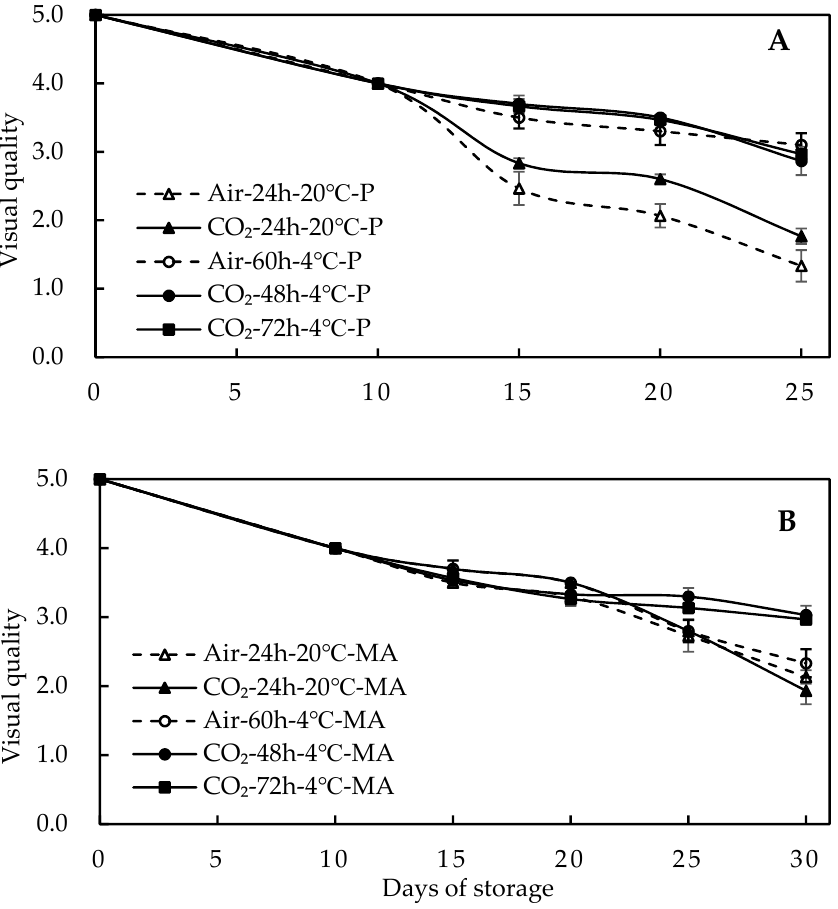
Figure 5. Changes in visual quality of green asparagus in P and MA packages. ( A ) Perforated packages (P); ( B ) 10,000 cc / m 2 · day · atm OTR-modified atmosphere packages (MA). Treatments of 60% CO 2 or air pretreated for 24 h at 20 ◦ C and 60% CO 2 treated for 48 h, 72 h or air for 60 h at 4 ◦ C were conducted. All groups were stored at 4 ◦ C until the final day. Values are presented as means ± SE ( n = 5).